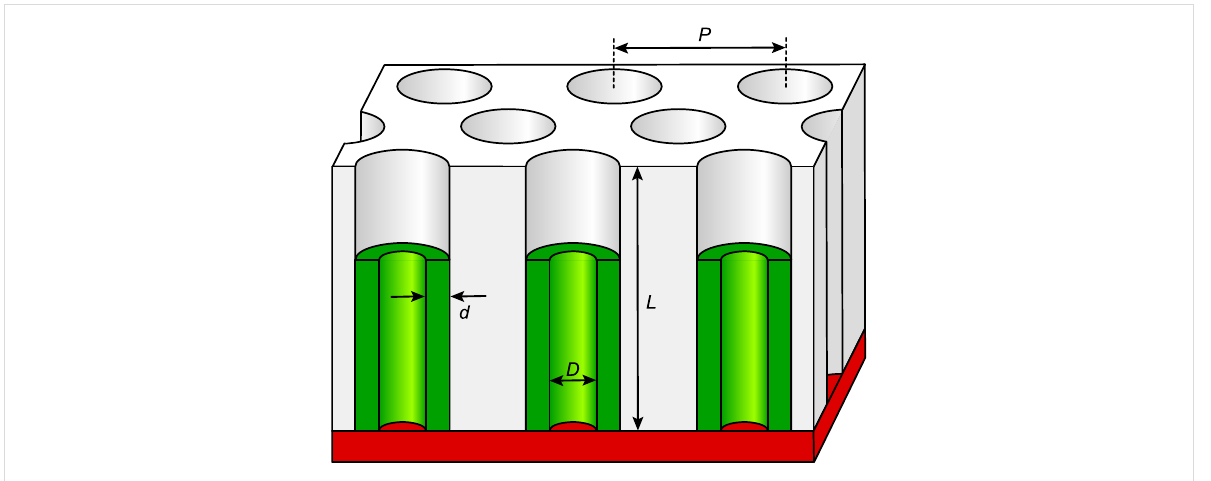
Figure 1: Schematic view of the proposed system, including all tunable geometric parameters. An inorganic matrix (white) defines cylindrical pores of length L and in a hexagonal order of period P . The silicon tubes (green) have a wall thickness d and an inner diameter D . The electrical contact is represented in red